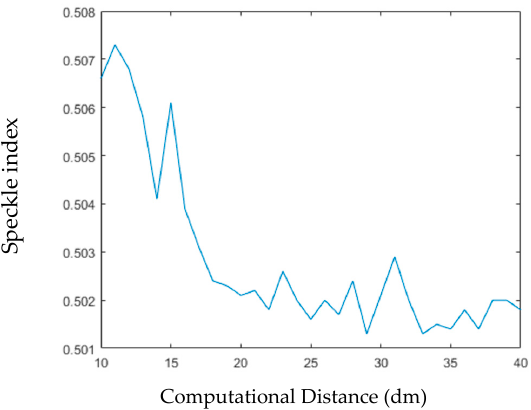
Figure 13. The Relationship between Computational Distance and Imaging Quality.